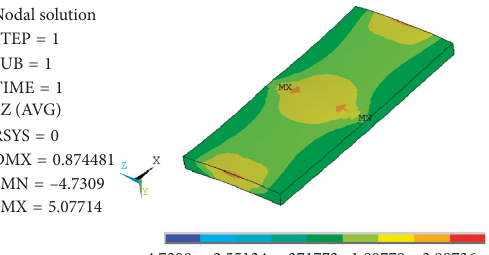
–4.7309 5.07714–2.55134–0.371772 1.80779 –3.64112 –1.46155 0.71801 2.89758